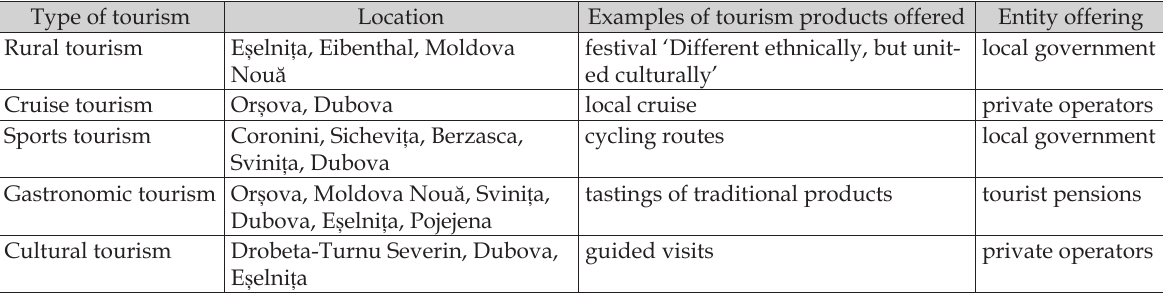
Table 1. Types of tourism present in the Danube Gorge